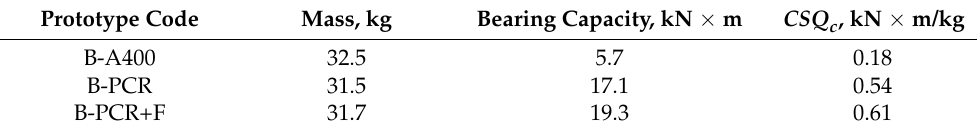
Table 11. The results of determining the structural characteristics of specimen beams.